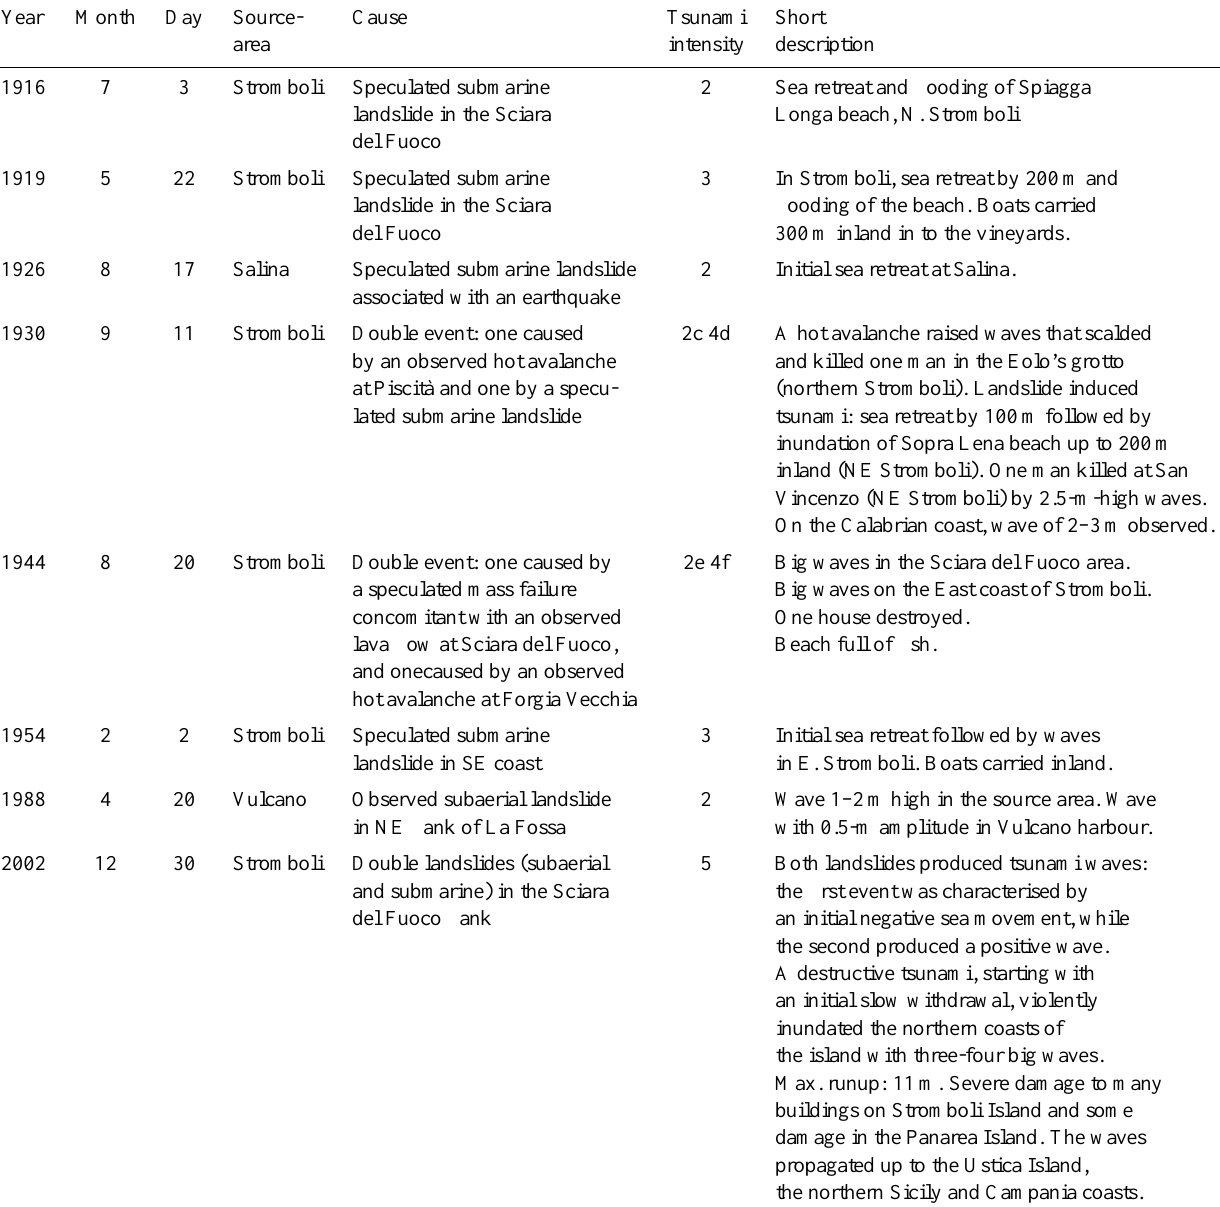
Table 1. Summary of Aeolian tsunamis with main tsunami parameters: time, source area, coordinates, cause, tsunami intensity, and descrip- tion (c=intensity of the tsunami due to the hot avalanche at Piscit`a; d=intensity of the tsunami observed in Punta Lena and in San Vincenzo; e=intensity of the tsunami observed in the Sciara del Fuoco; f=intensity of the tsunami observed in Forgia Vecchia). The tsunami intensity is expressed in the Sieberg-Ambraseys scale (Sieberg, 1927; Ambraseys,